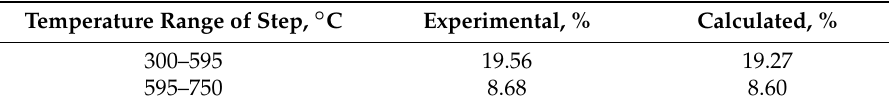
Table 1. Comparison of weight changes calculated from Equations (1)–(3) with the experimental values obtained from thermogravimetric